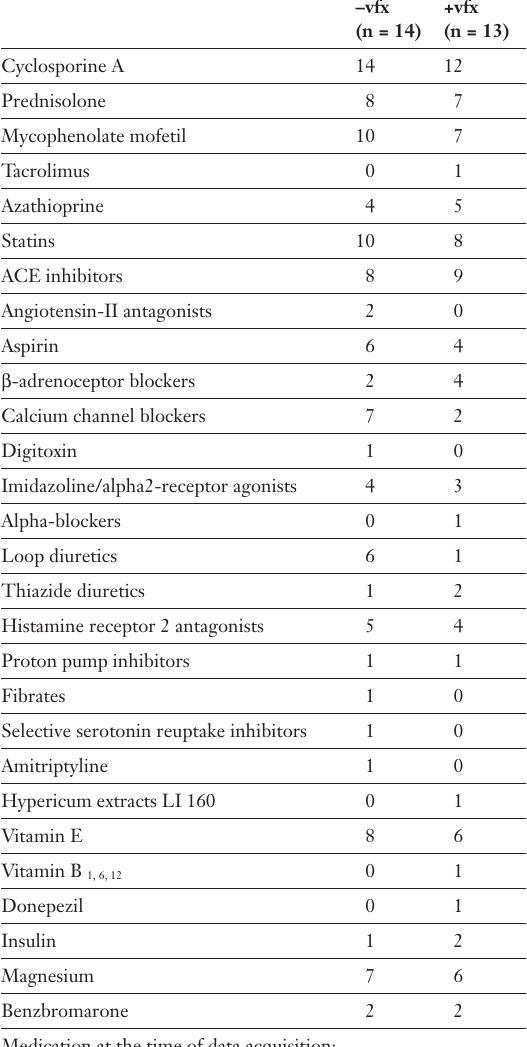
Immunosuppressive drugs and concomitant medication in patients without (–vfx) and with (+vfx) vertebral